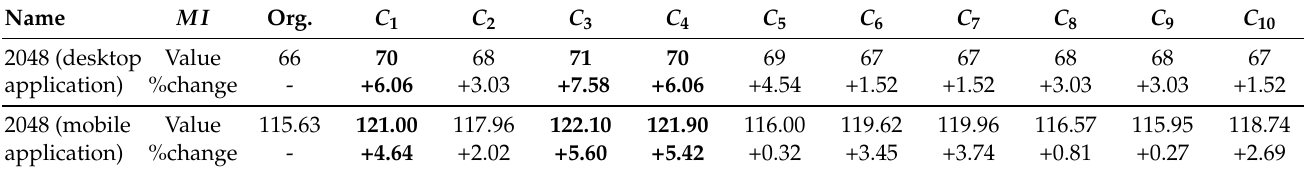
Table 6. The effect of the maintainability index on the combinations in the source code of the applications and the percentage change rates of the